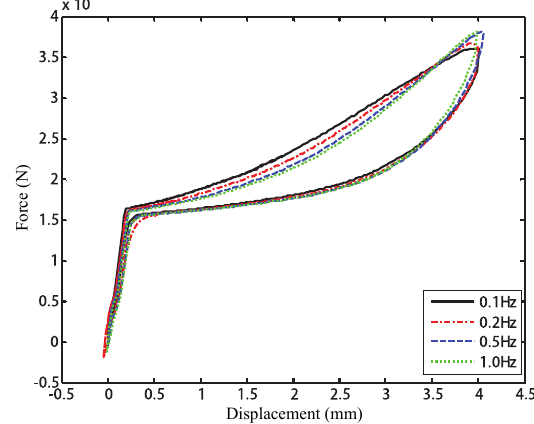
Fig. 4. Hysteresis curves under 2 mm amplitude with various fre- quency excitations.